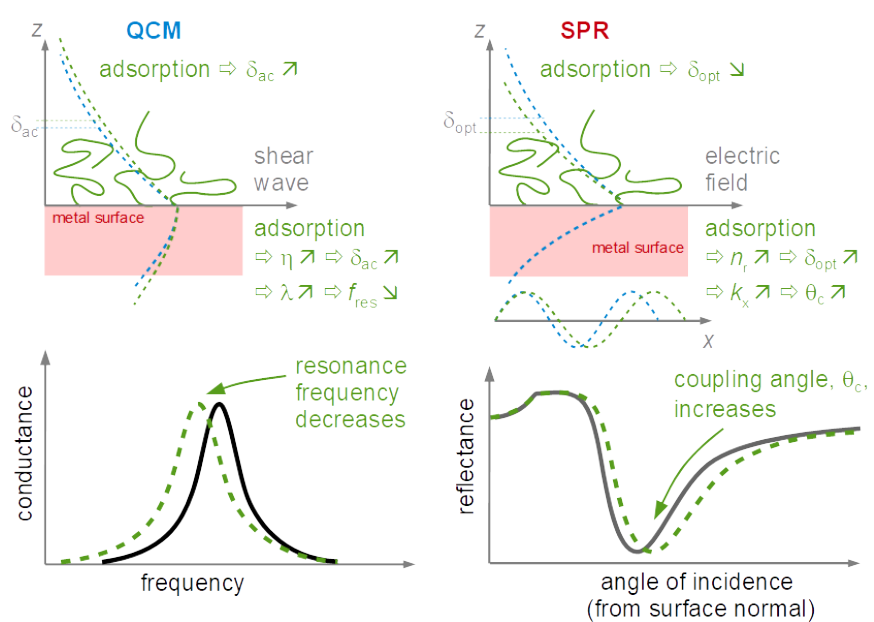
Figure 45. Both the QCM and SPR spectroscopy exploit the shift of a resonance condition. The peak in the conductance curve is the analog of a dip in the reflectance curve. The resonance frequency is replaced by the coupling angle (that is, the angle of incidence with minimum reflectance). The coupling angle is related to the plasmon’s k x -vector. The shift in the coupling angle is proportional to the adsorbed amount.